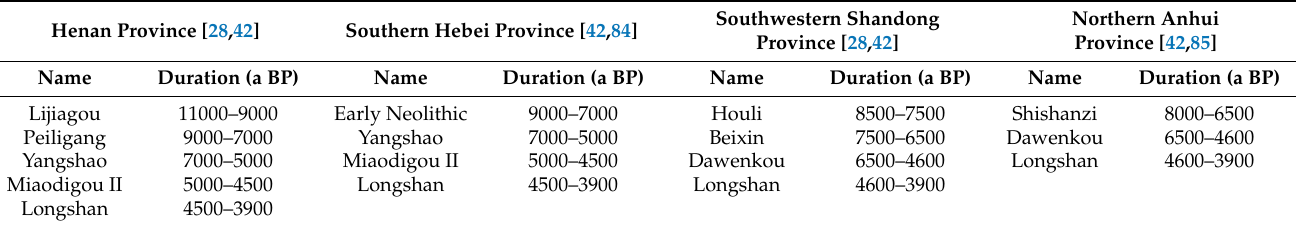
Table 1. Neolithic cultures in the four modern provinces of the lower Yellow River floodplain and the surrounding areas. Henan Province